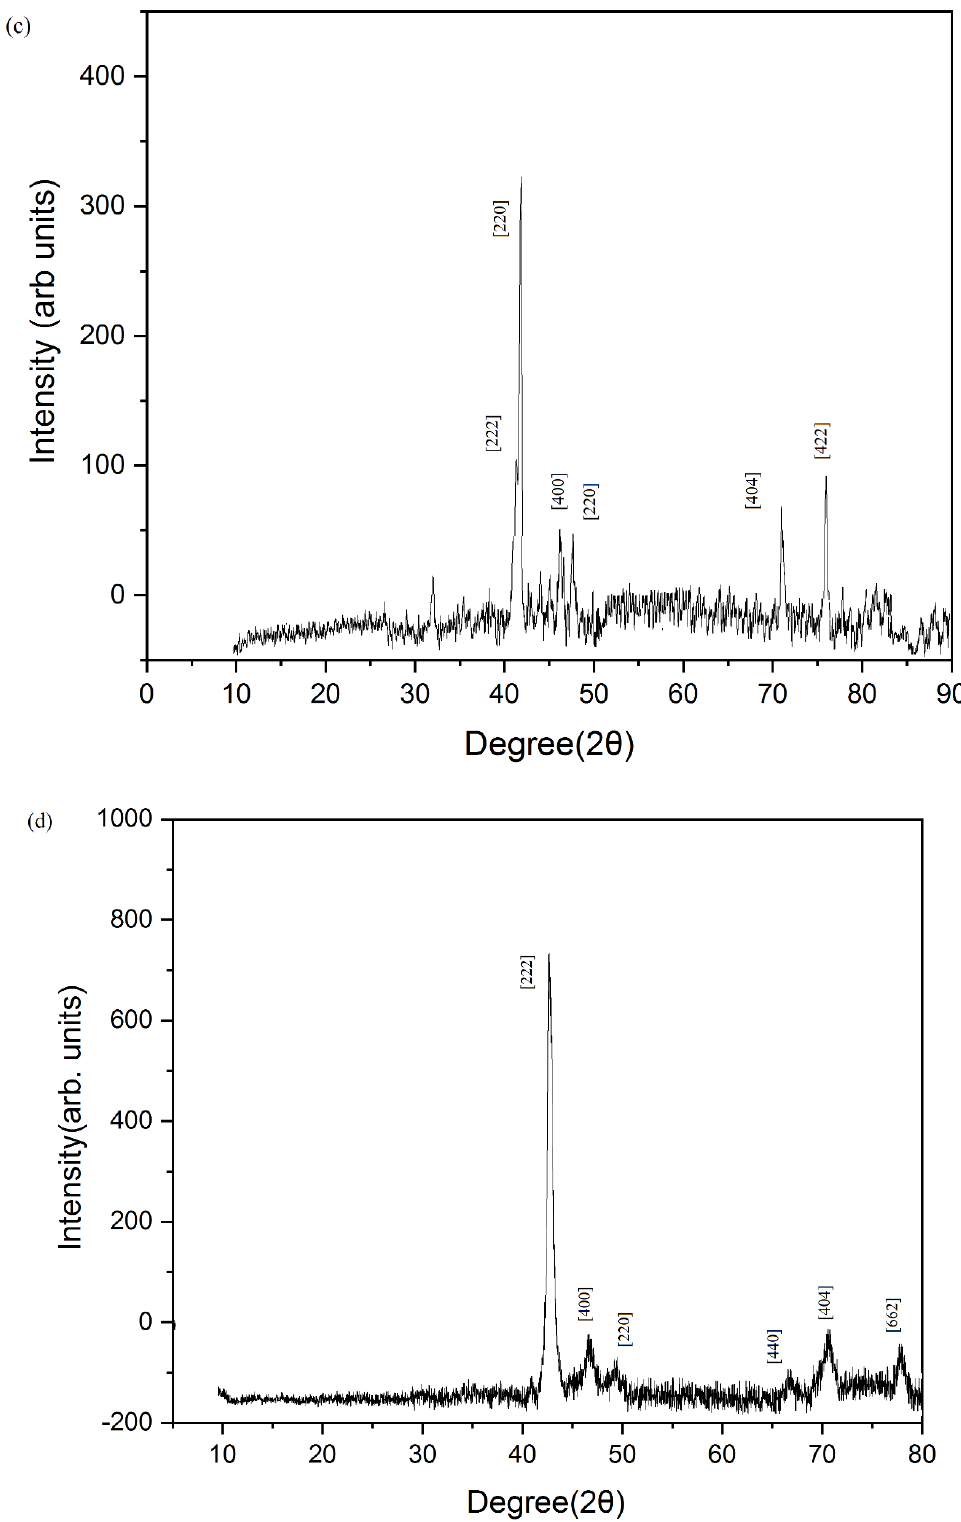
Figure 2. XRD representing the composition of the alloys in Ni 50 − x Fe x Mn 30 Sn 20 − y In y where 1 ≤ x ≤ 4; 2 ≤ y ≤ 8 alloys are represented in ( a – d ), respectively. The XRD analysis reveals that the alloy composition where x = 1 and y = 2 is in austenite phase. When the concentrations of constituent elements added to the alloys are increased, a coexisting phase can be observed at x = 3 and y = 6, while a